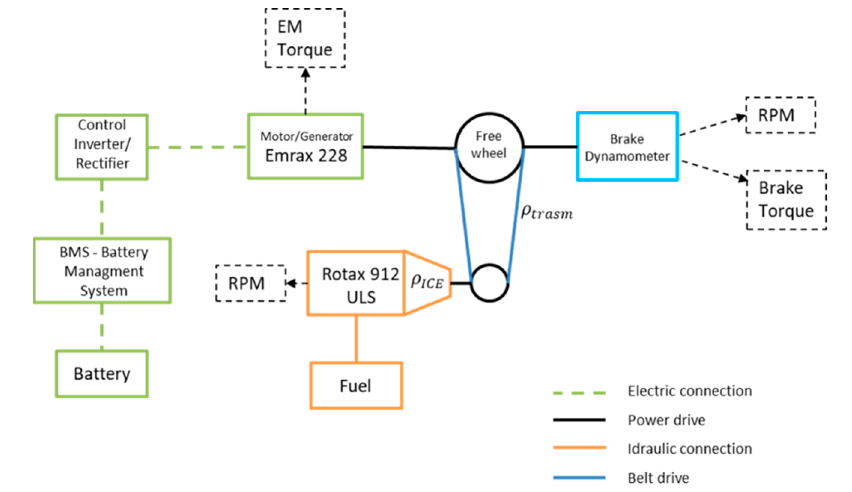
Figure 1. Parallel hybrid propulsion system adopted scheme.